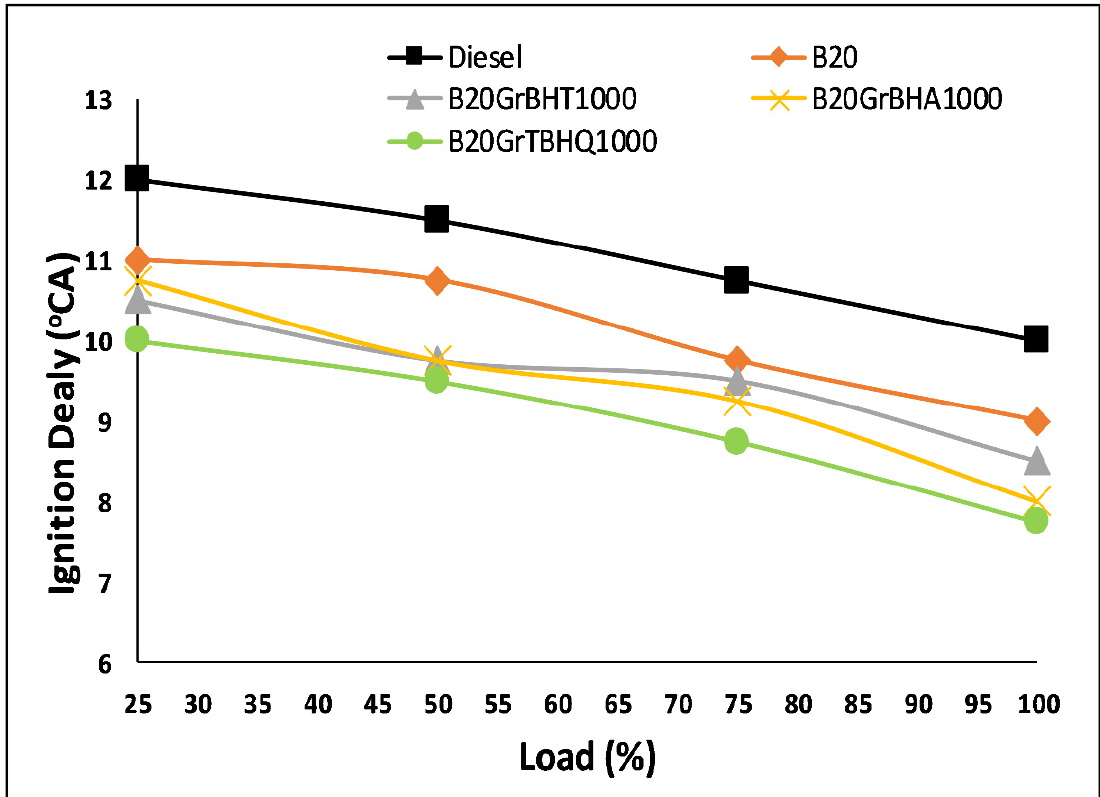
Figure 5. Deviation of ignition delay with respect to loading.